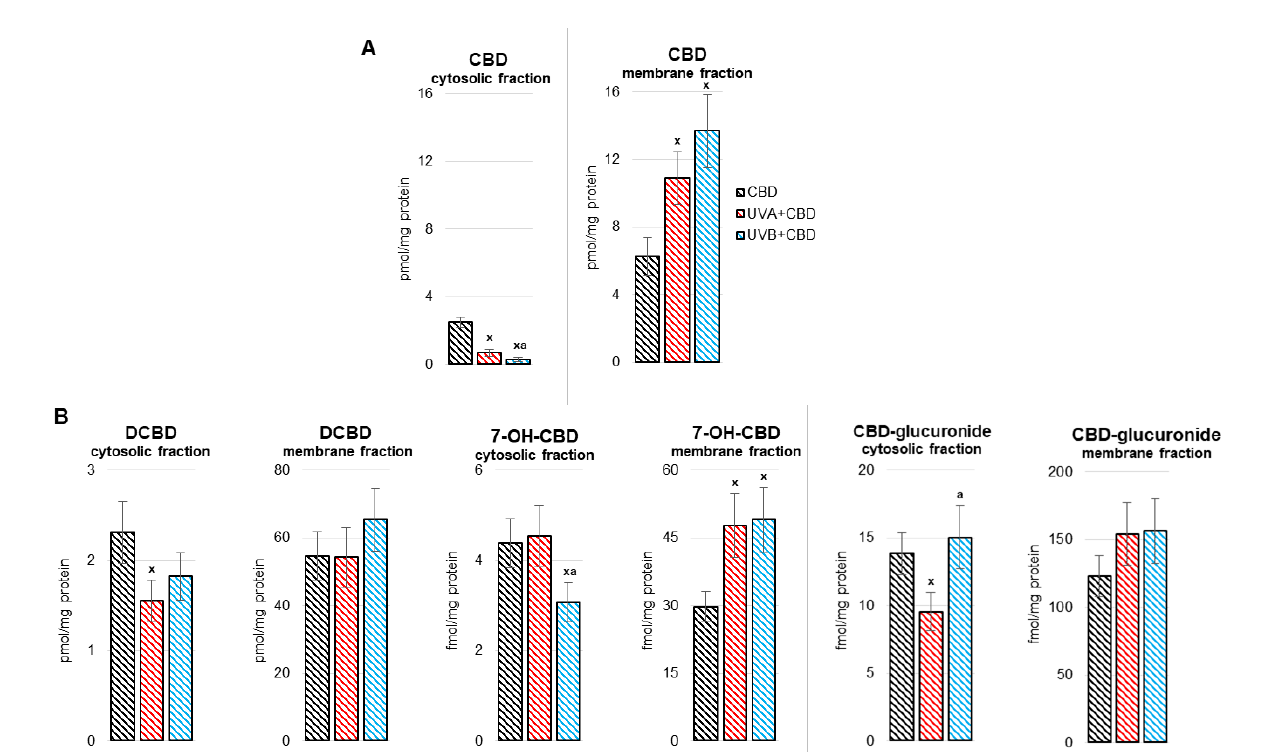
Figure 1. The level of cannabidiol (CBD) ( A ) and CBD metabolites (decarbonylated cannabidiol (DCBD), 7-hydroxycannabidiol (7-OH-CBD), cannabidiol-glucuronide) ( B ) in the liver (cytoplasm and membranes fraction) of nude rats in the following groups: treated with CBD (every 12 h) for 4 weeks; irradiated with UVA (every 48 h) and treated with CBD (every 12 h) for 4 weeks; irradiated with UVB (every 48 h) and treated with CBD (every 12 h) for 4 weeks. The mean values for six rats in each group ± SD are shown: x—differences vs. CBD group, p < 0.05; a—differences vs. cells irradiated with UVA (every 48 h) and treated with CBD (every 12 h) for 4 weeks, p < 0.05.